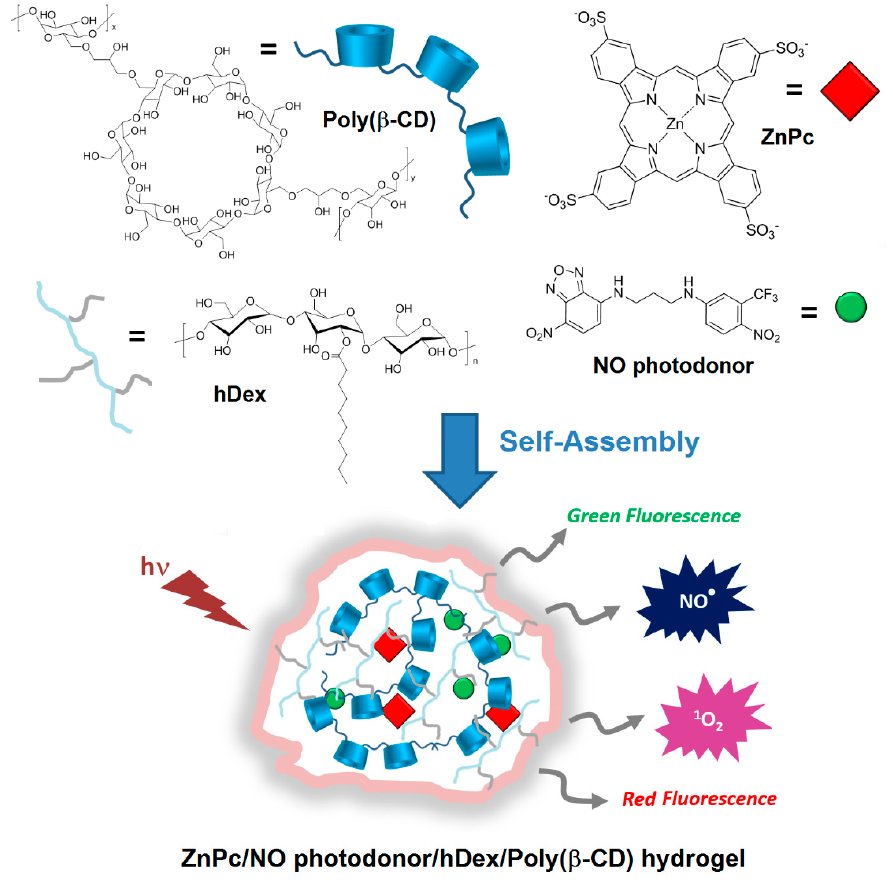
Figure 44. Molecular structure of Poly( β -CD), ZnPc, hydrophobically modified dextran (hDex), NO photodonor, and corresponding ZnPc/NO photodonor/hDex/Poly( β -CD) hydrogel. Adapted from Fraix; Gref; Sortino [177].